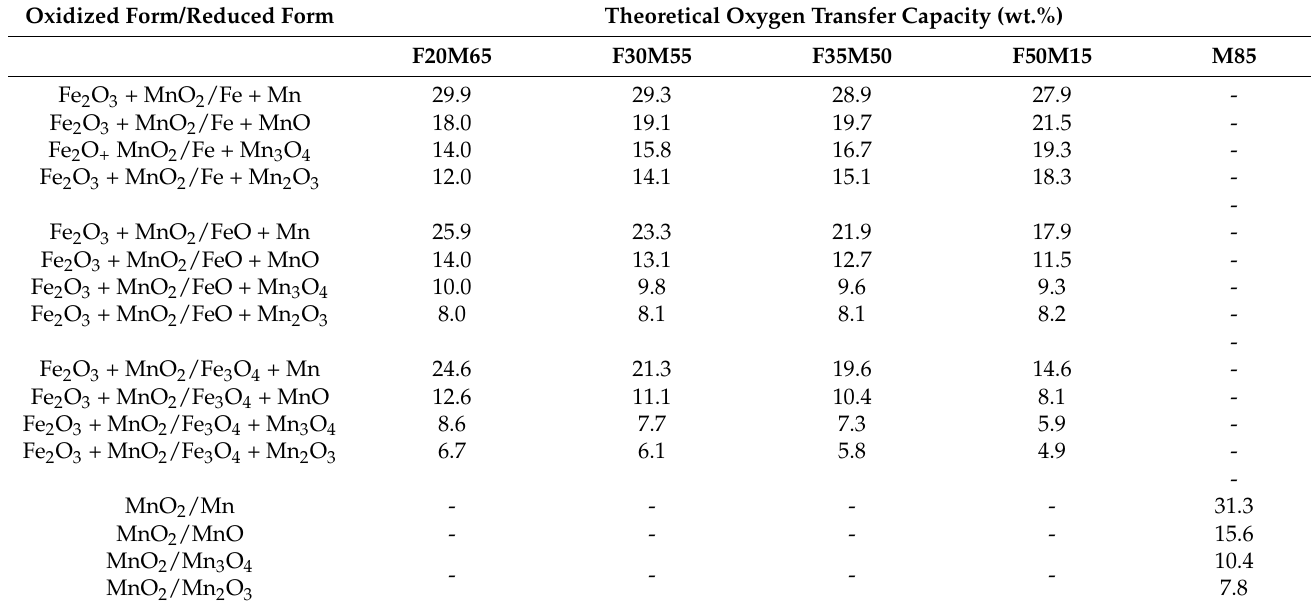
Table 2. Predicted oxygen transfer capacity of the oxygen carriers under different reduction states. Oxidized Form/Reduced Form Theoretical Oxygen Transfer Capacity (wt.%)